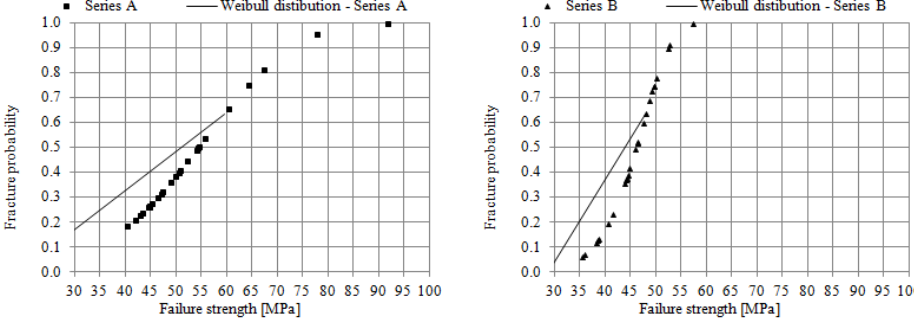
Figure 4: Weibull two-parameter probability distribution for sets A and B.